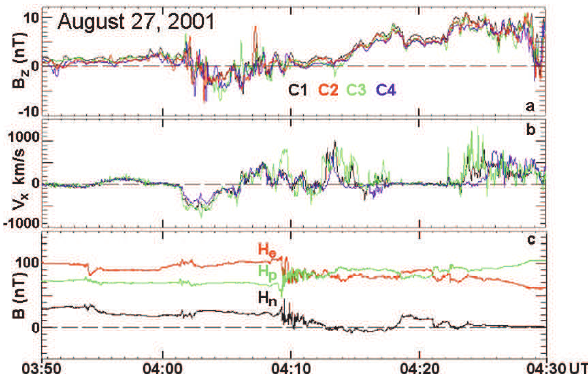
Fig. 15. (Upper and middle panel) Cluster FGM and CIS observa- tions of the B Z , GSM and ion earthward and tailward flows, (Lower panel) GOES magnetic field data for the parallel ( Hp green), earth- ward ( He , red) and normal ( Hn , black) components recorded dur- ing a substorm on 27 August 2001. (From Baker et al.